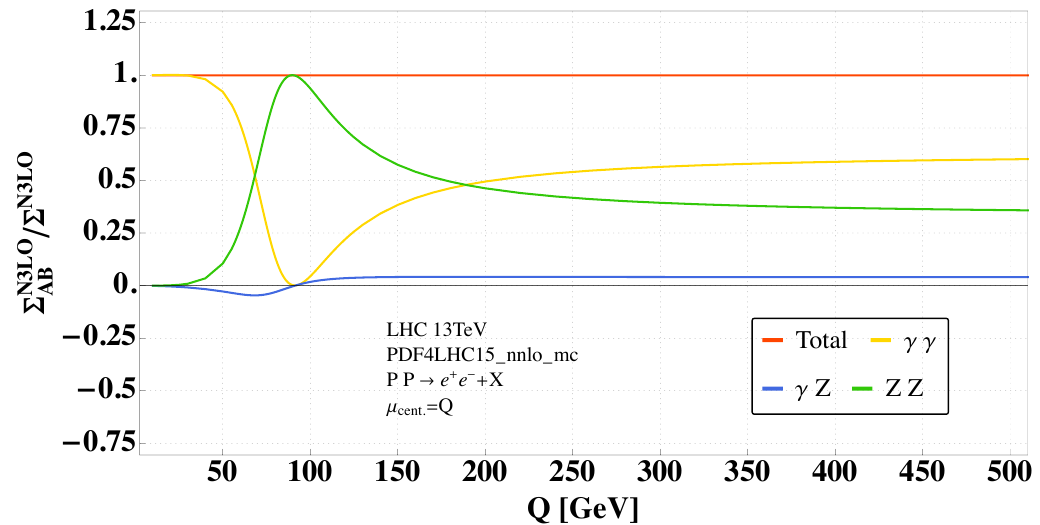
Figure 16. Relative contributions to the invariant-mass distribution from photon and Z exchange and their interference as a function of Q at third order in perturbations